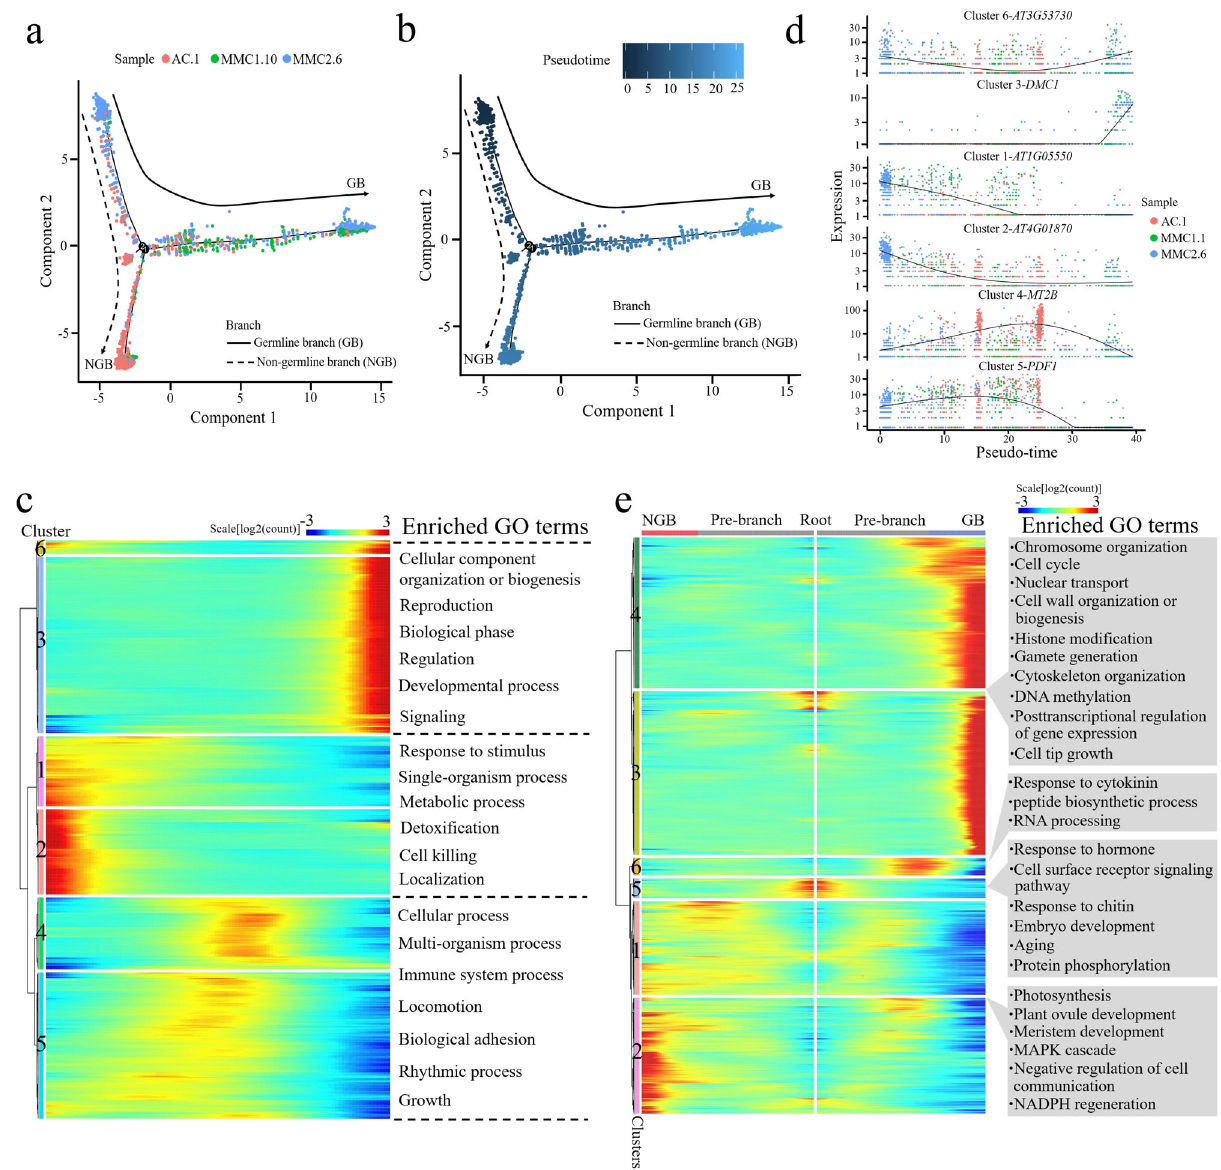
Fig. 4 Reconstruction of MMC differentiation trajectory in a pseudotime manner. a , b Pseudotime trajectory of MMC differentiation. The horizontal and vertical coordinates are two principal components, and the dots represent different cells, with different colors representing the sample identity ( a ) or the pseudotime ( b ). Color from darkest to lightest blue in ( b ) represents pseudotime from beginning to end. The black circles represent the different branch points, and the solid and dashed lines represent the trajectories of the germline branch (GB) and non-germline branch (NGB), respectively. c Expression heatmap of 1738 DEGs across pseudotime. The horizontal coordinate represents quasi-chronological order, and the vertical coordinate represents one gene per row. Rows were grouped based on similarity of gene expression, resulting in the six clusters indicated at the left. The color bar indicates the relative expression level. Representative GO terms are listed at the right. d Expression values of a representative gene in each cluster along the pseudotime axis. The abscissa represents the quasi-chronological order, and the ordinate represents the relative expression value of genes. The black line denotes the smoothed average expression. e Branched heatmap showing 4020 DEGs with branch-speci fi c expression patterns in pseudotime. The root of the tree is in the middle of the plot, and expression from the earliest cells to the non-germline cells of the NGB is shown progressing to the left, whereas the germline cell progression in the GB is shown progressing to the right of the root. The color bar indicates the relative expression level. Representative GO terms are listed at the